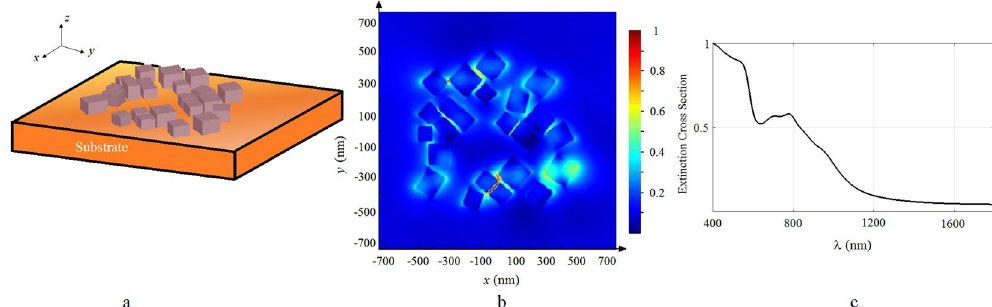
Figure 10. ( a ) The simulated area is 1 μ m × 1 μ m where size of copper oxide nanocubes range from 85 nm up to 150 nm, inter-particle gaps range from 10 nm to 350 nm . ( b ) Electric field amplitude distribution at 50 nm above the surface at SPR resonance of 794 nm . ( c ) The extinction cross section of this assembly of nanocubes as a function of wavelength.